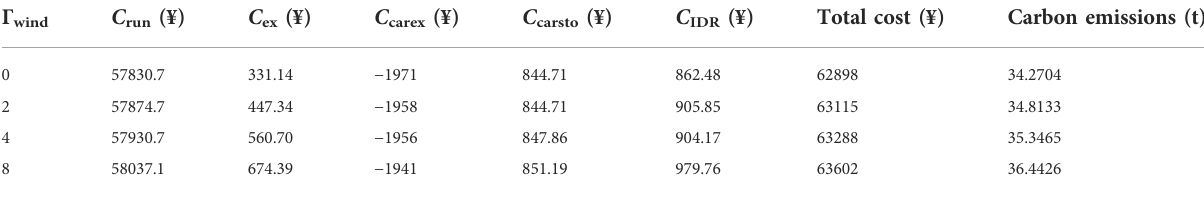
TABLE 4 Robust optimization results under different budget Γ wind